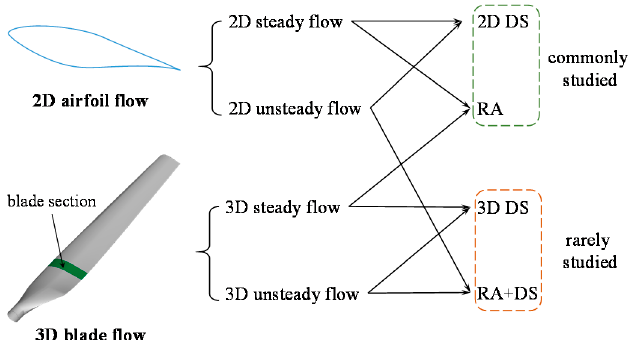
Figure 1. Schematic of comparative studies of aerodynamic characteristics between the wind turbine airfoil and blade section. ‘RA’ denotes rotational augmentation, ‘DS’ dynamic stall, and ‘RA+DS’ combined effect of rotational augmentation and dynamic stall.